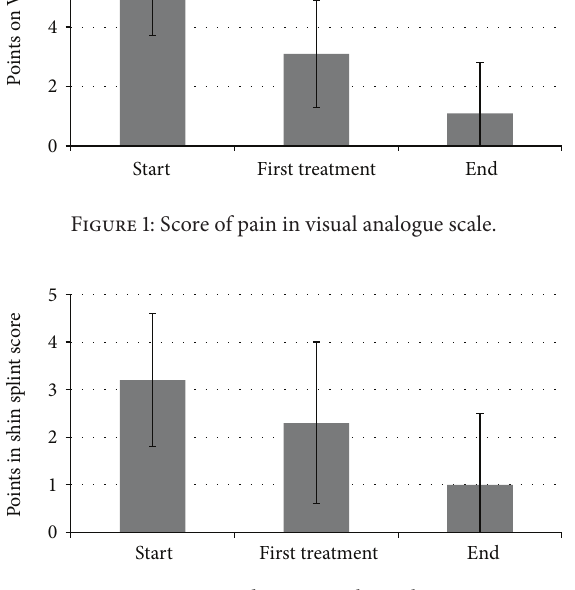
Figure 2: Running distance in shin splint